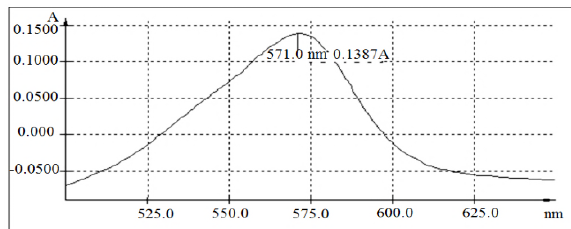
Fig. 3. Absorption spectrum of a solution of fructose P (3.3·10 -6 μg) in an acidic medium by α-naphthol The maximum absorption of fructose and glucose is in the visible area at (572±2) nm, but their intensity (with the same concentration of monosaccharides) has a difference of approximately 2 times, because their sensi- tivity to α-naphthol is different. According to the litera- ture, it has been shown that the addition of boric acid and urea supplements may suppress individual color reac- tions of monosaccharides [18]. The effects of additives of boric acid and urea (different concentrations) on the absorption spectra of fructose and glucose solutions with α-naphthol were studied (Fig. 4, 5).